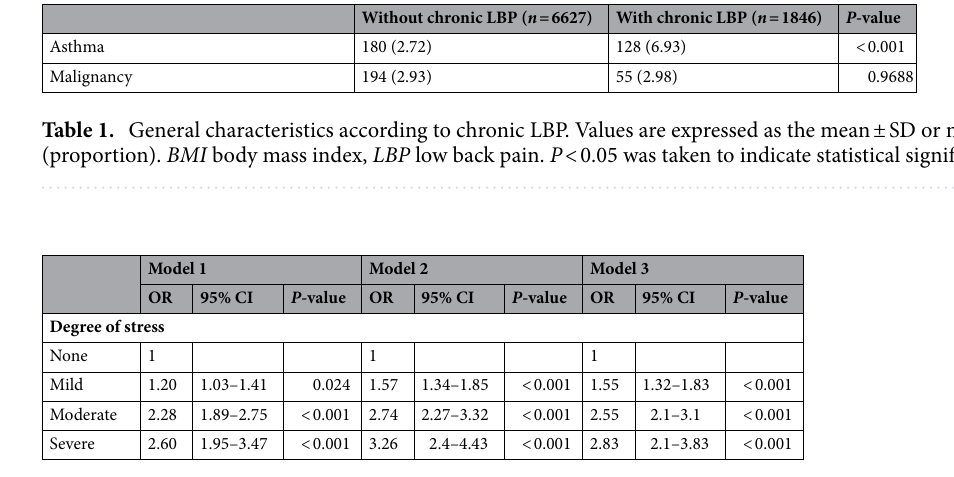
Table 2. Association between chronic LBP and degree of stress on multiple logistic regression analysis. Model 1, no adjustments for other variables; Model 2, adjustments for sex and age; and Model 3, adjustments for sex, age, and other environmental factors, such as obesity, sleep duration, smoking, alcohol consumption, education level, household income, occupation, physical activity, and comorbidities. CI confidence interval, LBP low back pain, OR odds ratio. P < 0.05 was taken to indicate statistical significance.